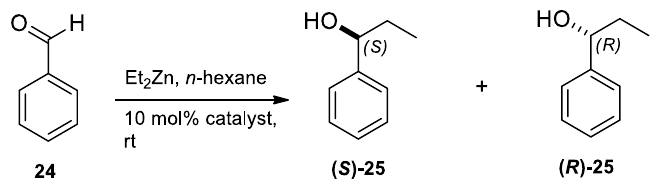
Table 2. Addition of diethylzinc to benzaldehyde, catalyzed by aminodiol derivatives .